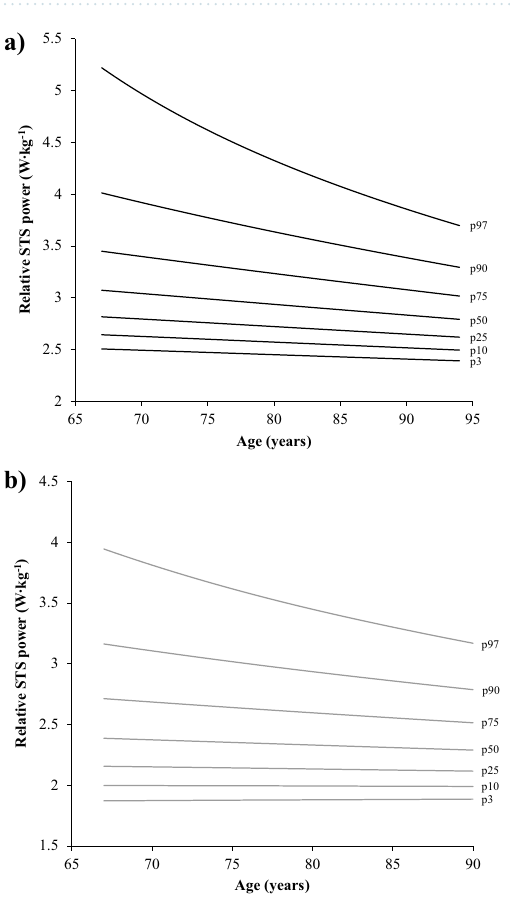
Figure 4. Normative values of relative STS power in men ( a ) (n = 337) and women ( b ) (n = 413) with relative STS power values above the identified thresholds of ≥ 2.5 and 1.9 W kg −1 for men and women, respectively. STS sit-to-stand, p